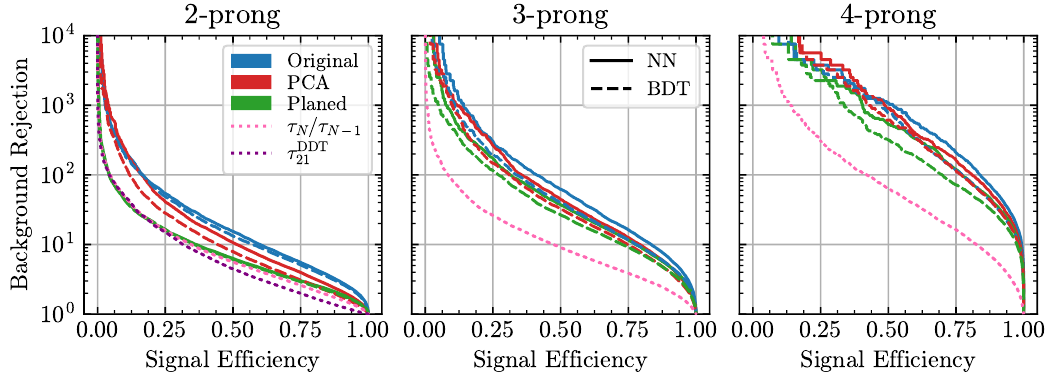
Figure 13: ROC curves for the 2-, 3-, and 4-prong signal jets versus QCD background for the methods which augment the data to decorrelate the jet mass rather than augment the training. The dashed and solid lines show the gradient boosted decision trees (BDT) and neural networks (NN), respectively. The blue, red, and green curves are for the data which has not been altered, data which uses the PCA rescaling, and data which has the jet mass planed away. The dotted lines show the results using a single combination of the N-subjettiness variables. Generally the BDTs have slightly worse background rejection than the NNs. Similarly, the PCA rescaling based methods tend to be between the unaltered methods and the planing methods, which are better than the single variable